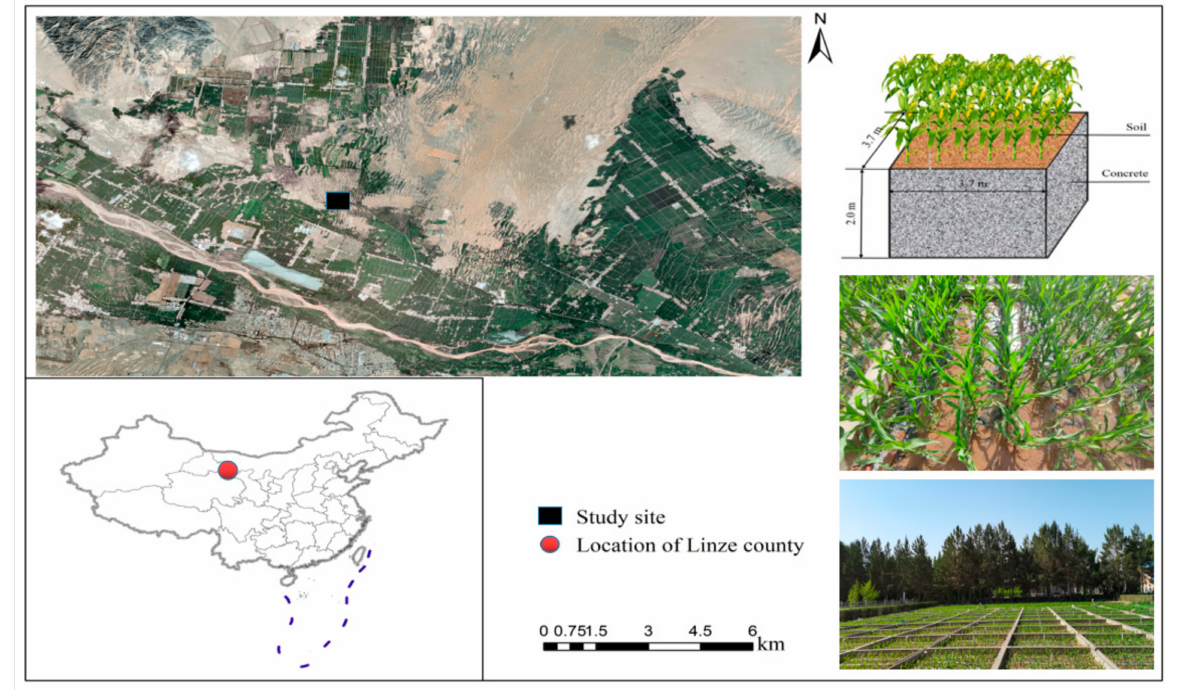
Figure 4. Location of the study site.